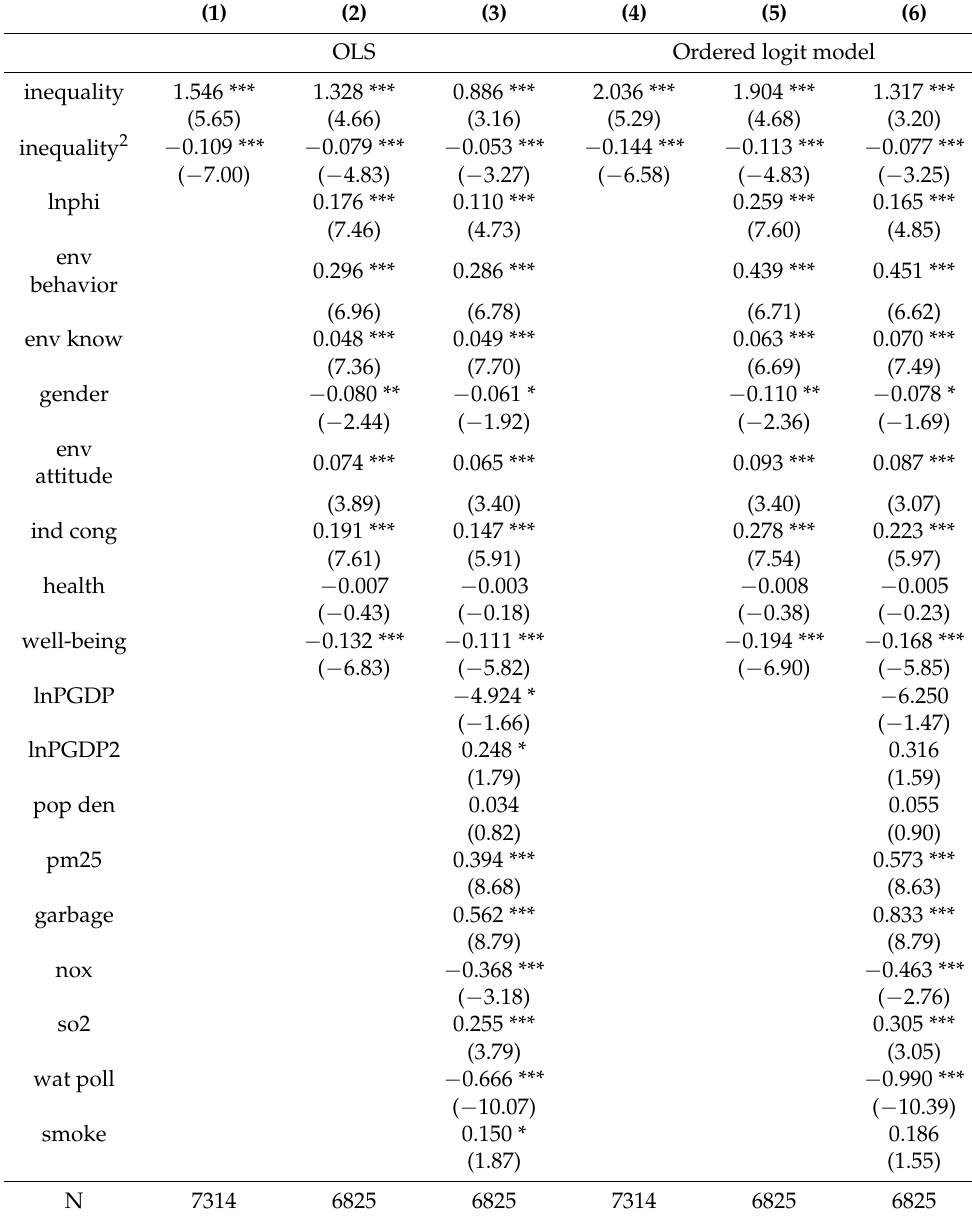
Table 2. The effect of individual-level income inequality on subjective environmental pollution: baseline